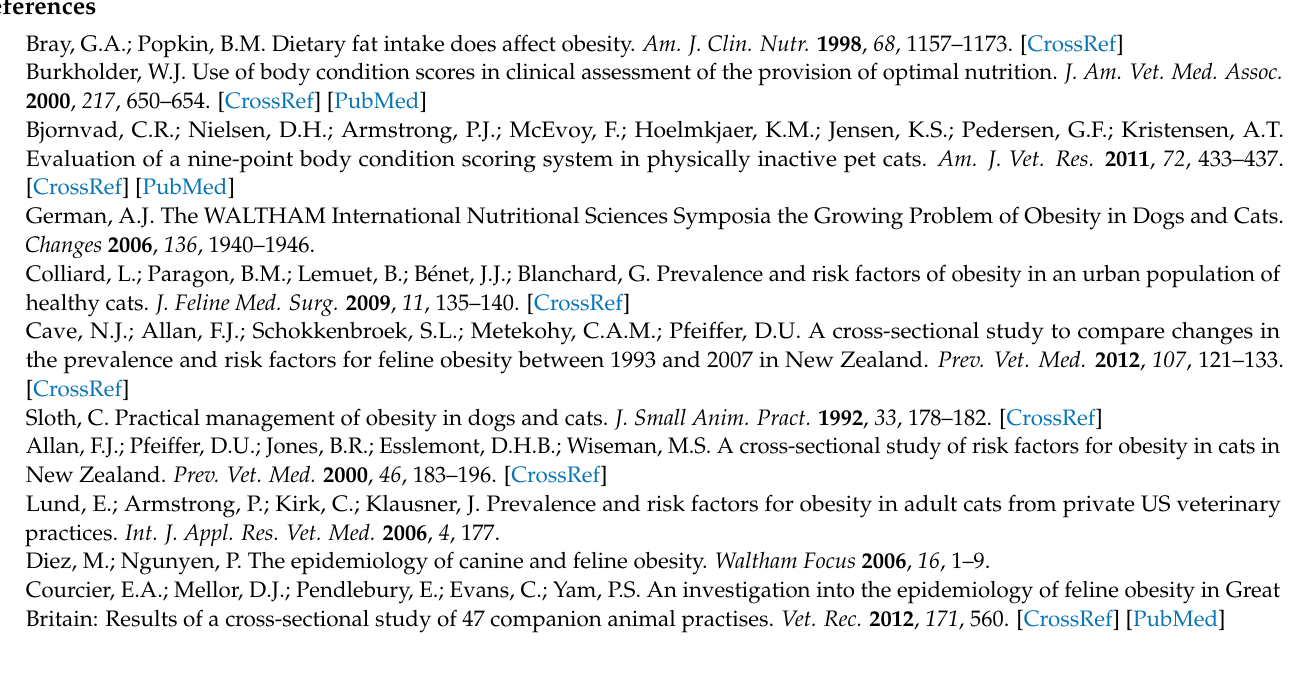
Figure S2: 5 point-scale BCS chart included in the questionnaire for cat owners’ self-assessment on the body condition of their cats, Table S1: Demographic characteristics and general management of the cat, Table S2: Association between overweight and factors related to demographic characteristics and general management of cat. Results of univariate logistic regression analysis, Table S3: Results of bi-variable logistic regression analysis. Association between overweight and factors related to food management, Table S4: Results of bi-variable logistic regression analysis. Association between overweight and factor related to playful and aggressive behaviors, Table S5: Independent predictors of overweight. Results of multivariable